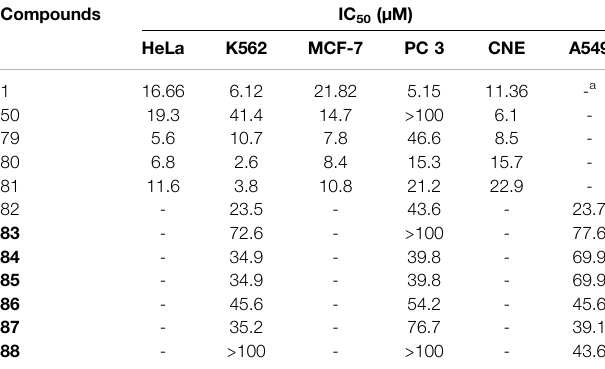
TABLE 2 | The anti-proliferation effect of tanshinone I derivatives on a variety of cancer cell lines (IC 50 μ M). Compounds